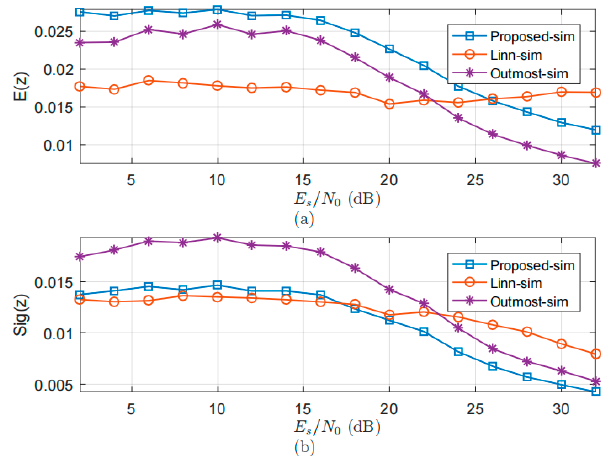
Figure 7. Expectation and variance versus SNR under the condition that carrier synchronization is unlocked for the 32APSK signal: ( a ) expectation; ( b ) variance.